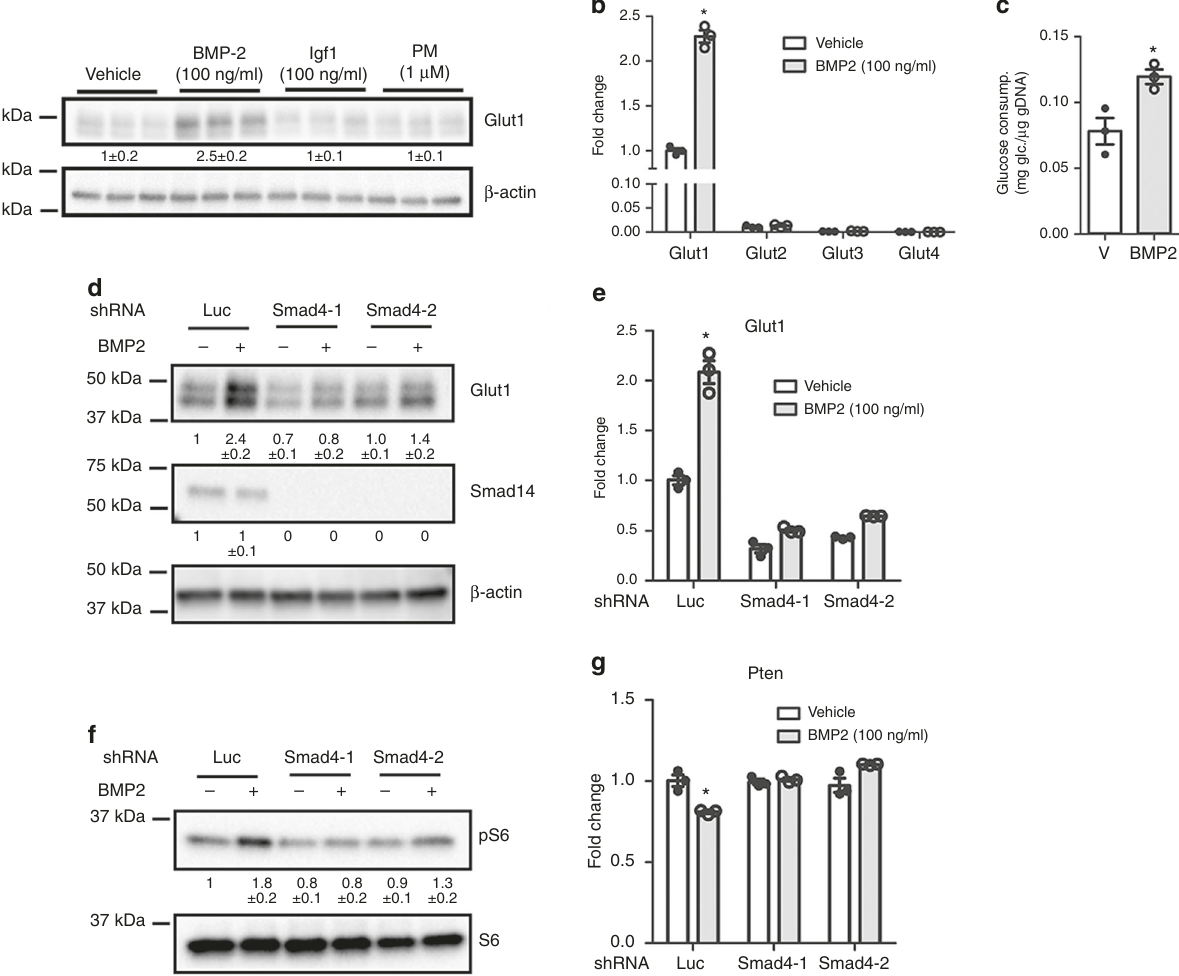
Fig. 8 BMP2 induces Glut1 expression via Smad4 and mTORC1. a Western blot analyses of primary chondrocytes after 24 h of treatment as indicated. b RT-qPCR analyses in primary chondrocytes with or without BMP2 treatment for 24 h. * p < 0.05, n = 3, error bar indicates SD, two-tailed Student ’ s t- test. c Glucose consumption by primary chondrocytes with or without BMP2 treatment for 48 h. Data normalized to genomic DNA. * p < 0.05, n = 3, error bar indicates SD, two-tailed Student ’ s t -test. d , e Effects of Smad4 knockdown on Glut1 induction by BMP2 assayed by western blot ( d ) or RT-qPCR ( e ). shLuc used as negative control. Two different Smad4 shRNA used. * p < 0.05, n = 3, error bar indicates SD, two-tailed Student ’ s t -test. f Western blot analyses of Smad4 knockdown on BMP2-induced mTORC1 activation. g RT-qPCR analyses of Pten mRNA. * p < 0.05, n = 3, error bar indicates SD, two-tailed Student ’ s t -test. Quanti fi cation of all western blots denotes average fold change over vehicle control after normalization to β -actin ( a , d ) or total S6 ( f ) (±SD, n =